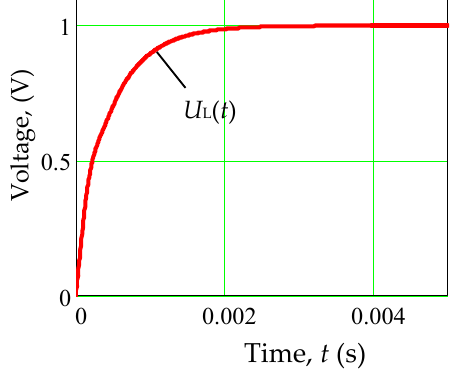
Figure 12. Transient response of a looped system.